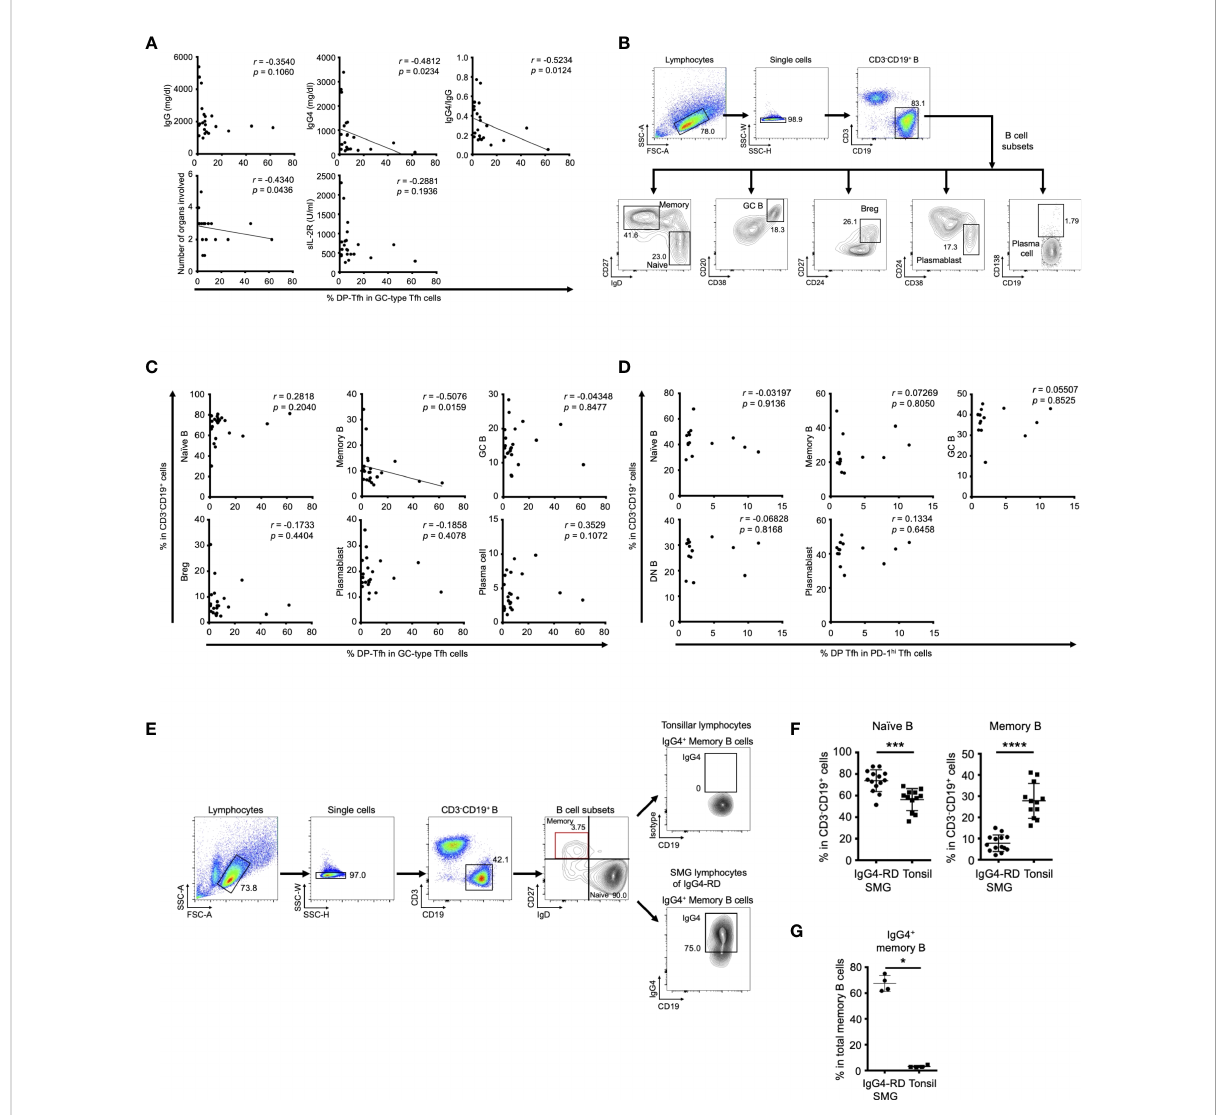
FIGURE 2 Clinical association of DP-Tfh cells in IgG4-RD lesions. (A) Scatter plots showing relationships between various clinical parameters associated with the IgG4-RD disease state and the ratios of DP-Tfh cells (CD3 + CD4 + CD8 + CXCR5 hi PD-1 hi ) to total GC-type Tfh cells (CD3 + CD4 + CXCR5 hi PD-1 hi ) in SMG lesions of IgG4-RD (n = 22). (B) Flow cytometry pro fi les showing selected windows and gating strategies applied to identify B cells (CD3 - CD19 + ) and B-cell subsets (naïve B cells, CD3 - CD19 + IgD + CD27 - ; memory B cells, CD3 - CD19 + IgD - CD27 + ; GC B cells, CD3 - CD19 + CD20 + CD38 + ; regulatory B cells, CD3 - CD19 + CD24 hi CD27 + ; plasmablasts, CD3 - CD19 + CD24 - CD38 + ; plasma cells, CD3 - CD19 + CD138 + ) in SMG lesions of IgG4-RD. (C) Scatter plots indicating the relationships between the ratios of various B-cell subsets and ratios of DP-Tfh cells to total GC-type Tfh cells in SMG lesions of IgG4-RD (n = 22) measured by fl ow cytometry. (D) Scatter plots indicating relationships between the ratios of various B-cell subsets and ratios of DP-Tfh cells to total GC-type Tfh cells in tonsils (n = 14) measured by fl ow cytometry. (E) Flow cytometry pro fi les showing selected windows and gating strategy for IgG4-expressing memory B cells of lymphocytes of tonsils and SMG lesions of IgG4-RD. (F) Naïve and memory B cells in SMG lesions of IgG4-RD (n = 14) and tonsils (n = 12) analyzed by fl ow cytometry. (G) High frequency of memory B cells expressing IgG4 (IgG4 + memory B cells) in SMG lesions of IgG4-RD analyzed by fl ow cytometry (IgG4-RD, n = 4; tonsil, n = 4). Data in (A, C, D) were analyzed by the Spearman ’ s rank correlation test, and data in (F, G) were studied by the Mann – Whitney U